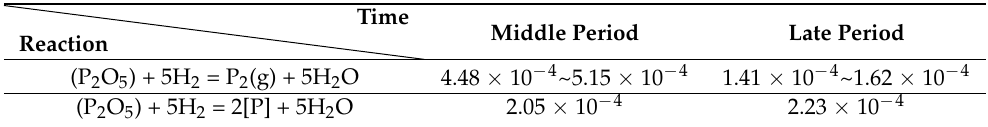
Table 13. Equilibrium ratios of water and hydrogen for the reactions (P 2 O 5 ) + 5H 2 = P 2 (g) + 5H 2 O and (P 2 O 5 ) + 5H 2 = 2[P] + 5H 2 O.